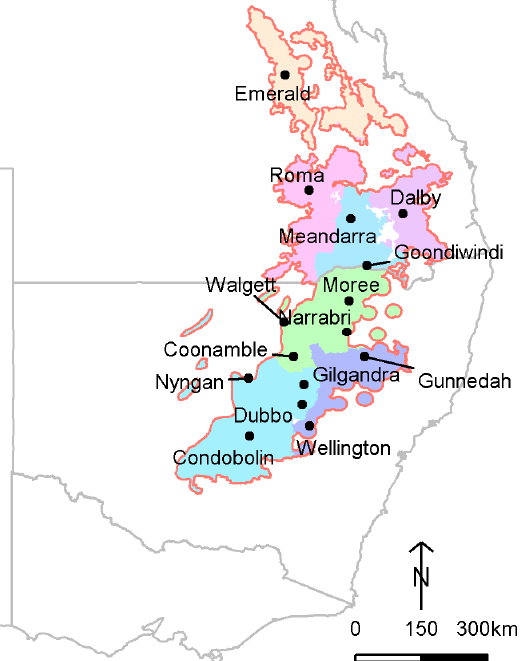
Figure 1. Map of the seven regions of the East Australian wheatbelt, with 15 sites chosen to represent those regions. Details on the locations can be found in Chenu et al., 2013 [22]. Table 1. Regions, locations, soil nitrogen at sowing and nitrogen fertilisation (in the baseline simulations), minimum pant available water (PAW) at sowing chosen to represent the East Australian wheatbelt. Initial and applied nitrogen (N) is indicated by ‘x-y-z-a’: x, initial N present in the soil at sowing; y, N applied at sowing as urea; z and a, N applied as nitrate at the stages ‘beginning of stem elongation’ and ‘mid-stem elongation’, respectively. Nitrogen Minimum PAW at Region Location Lat. Long. (kg ha − 1 ) Sowing